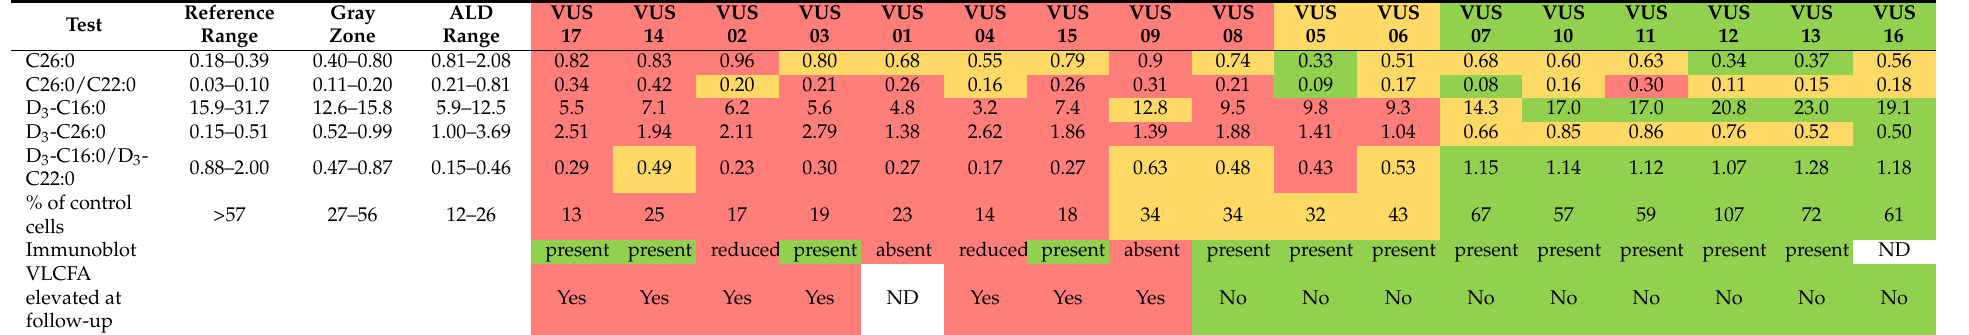
Table 4. VLCFA levels and D 3 -C22:0 loading test results of the VUS individuals compared to the ALD patients and control